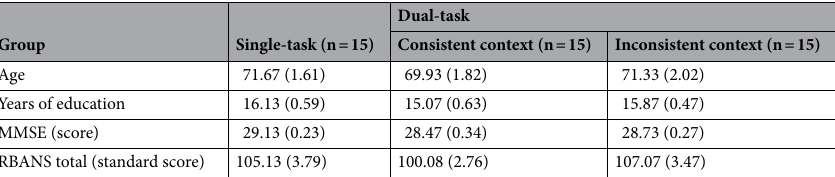
Table 2. Mean age, years of education, Mini-Mental State Examination (MMSE) 43 , and repeatable battery for the Assessment of Neuropsychological Status (RBANS) 44 for each of the three older adult groups. Numbers in the parentheses indicate